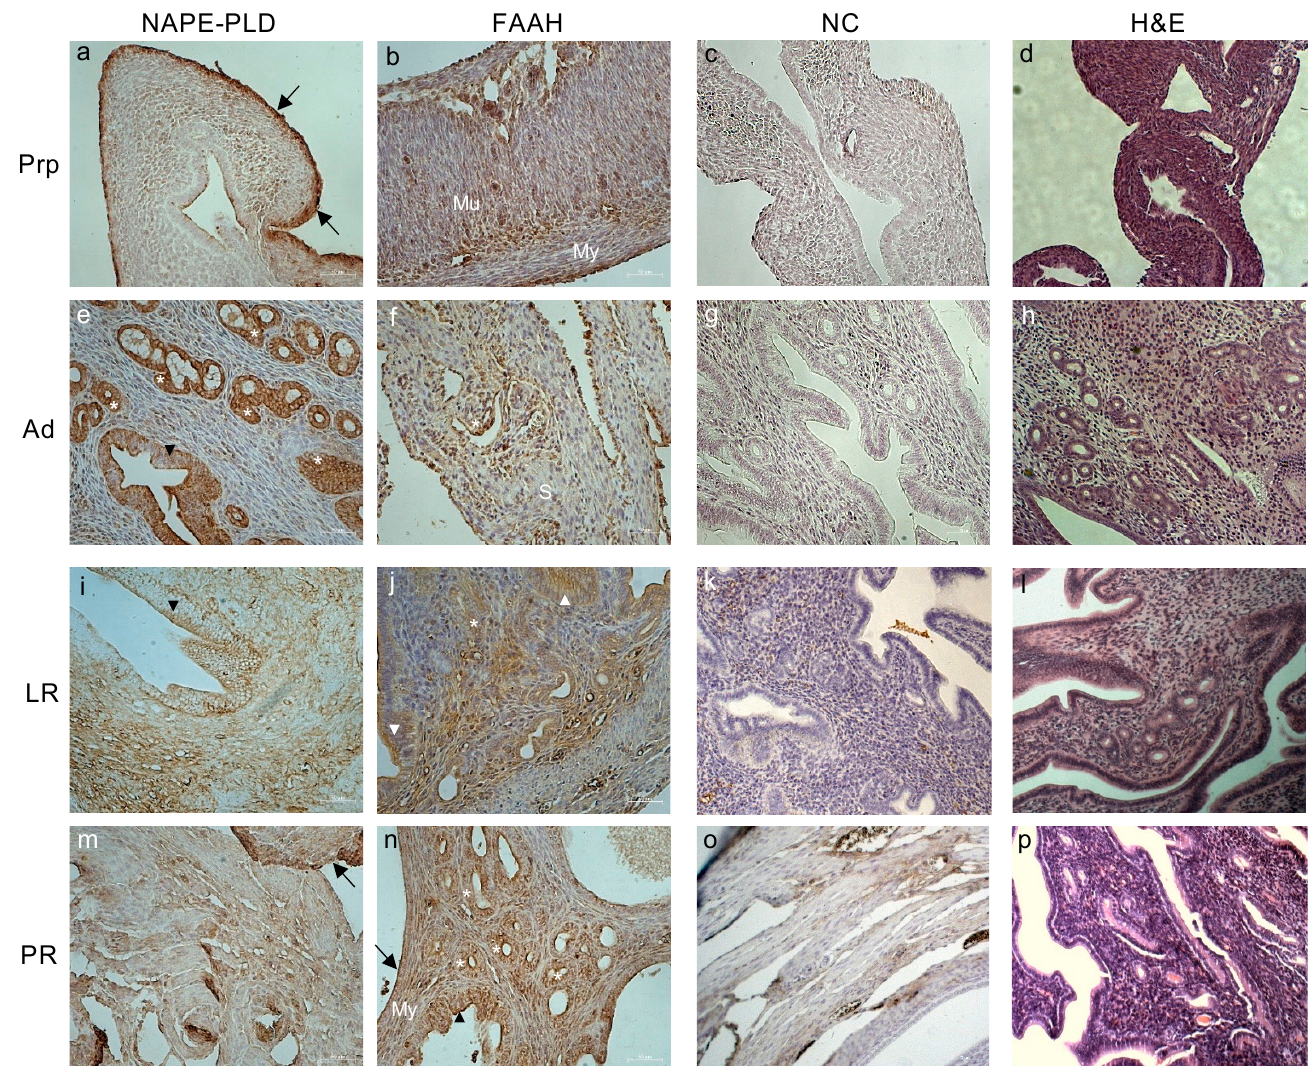
Figure 4. Representative images of tissue localization of NAPE-PLD and FAAH in mice uteri during reproductive aging. Representative images of NAPE-PLD ( a , e , i , m ) and FAAH ( b , f , j , n ) immunore- activity in prepubertal (PrP), adult (Ad), late reproductive (LR), and post-reproductive (PR) mouse uteri. Negative controls (NC; ( c , g , k , o )) and H&E staining ( d , h , l , p ) are also presented. Annotations and abbreviations—Arrows: perimetrium; arrowheads: columnar epithelium; asterisks: glands; My: myometrium; Mu: mucinous compartment; S: stroma. Scale bar: 50 µ m. Magnification: ×